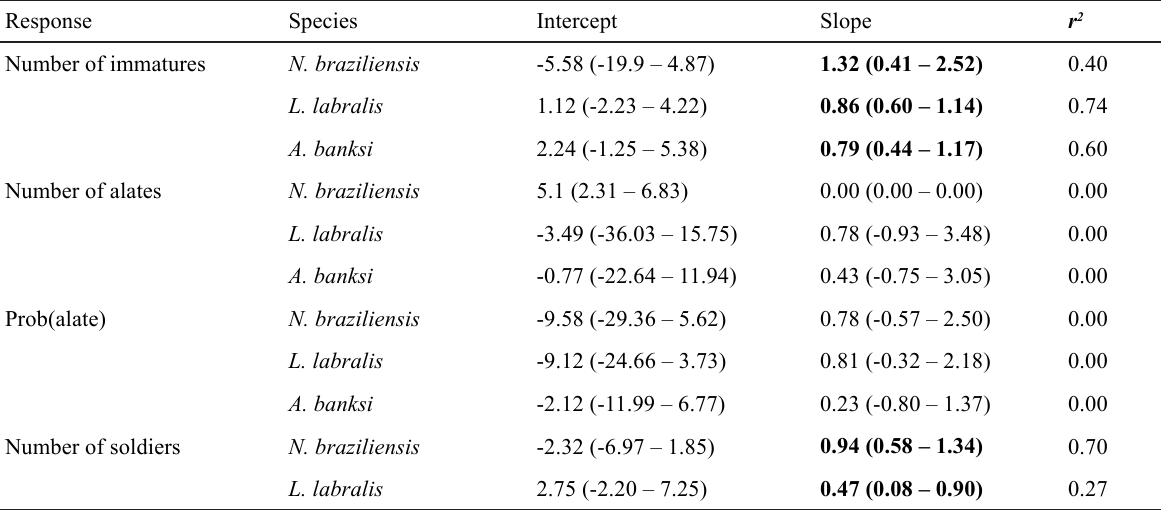
Table 2 . Summary of GLM results on the scaling of caste numbers with worker number in three Amazonian termite species. Numbers of immatures, alates and soldiers were modeled assuming Poisson-distributed errors (corrected for overdispersion) and log link. Prob(alate), or the probability of producing alates, was modeled using alate presence-absence and assuming binomial errors and logit link. Worker number was log-transformed in all analyzes. Numbers in parentheses are 95% confidence limits; numbers in bold are slopes significantly different from zero. N. braziliensis : Neocarpitermes braziliensis ; L. labralis : Labiotermes labralis ; A. banksi : Anoplotermes banksi